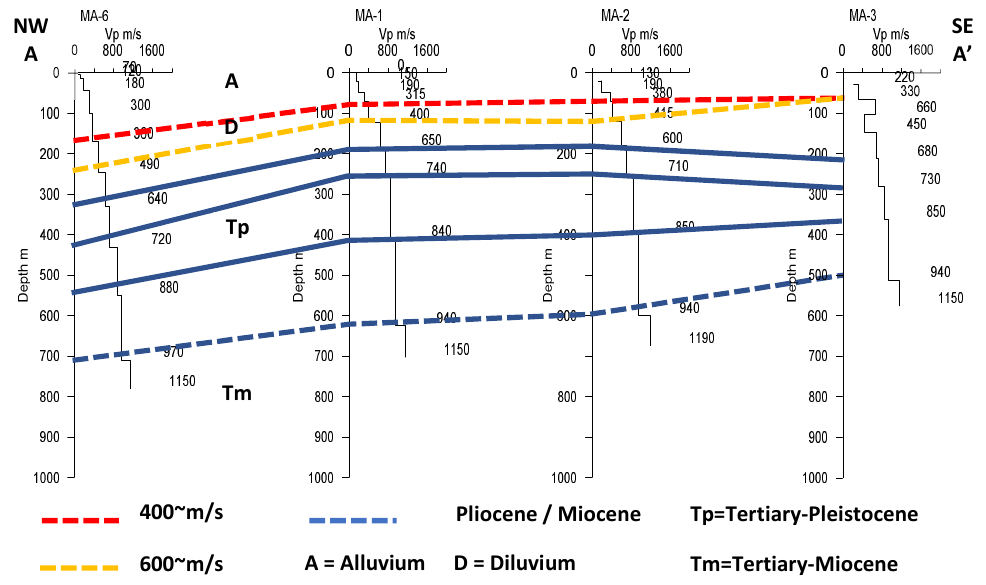
Figure 5. Shear-wave velocity (Vs) structure in NW and SE